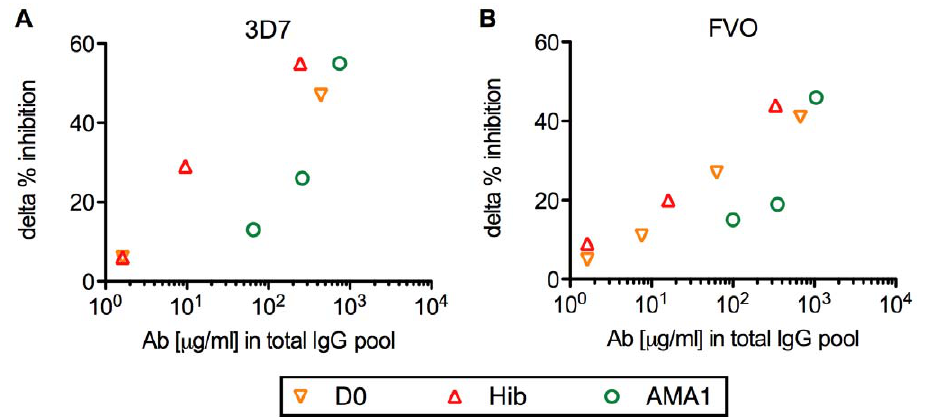
Figure 4. The correlation between anti-AMA1 antibody levels in the original total IgG pool and the interference effect of the corresponding non-AMA1 IgG. Anti-AMA1(3D7) (A) or anti-AMA1(FVO) (B) antibody levels ( m g/ml) in the original total IgG pools ( x -axis) are plotted against delta % inhibition of non-AMA1 IgGs ( y -axis) tested with P. falciparum 3D7 (A) or FVO (B) parasites. Delta % inhibition of each non- AMA1 IgG was calculated using the data presented in Figure 3 as follows: delta % inhibition = (% inhibition of the US-total IgG alone (black bar in Figure 3)) - (% inhibition of a mixture of the non-AMA1 IgG and US-total IgG).